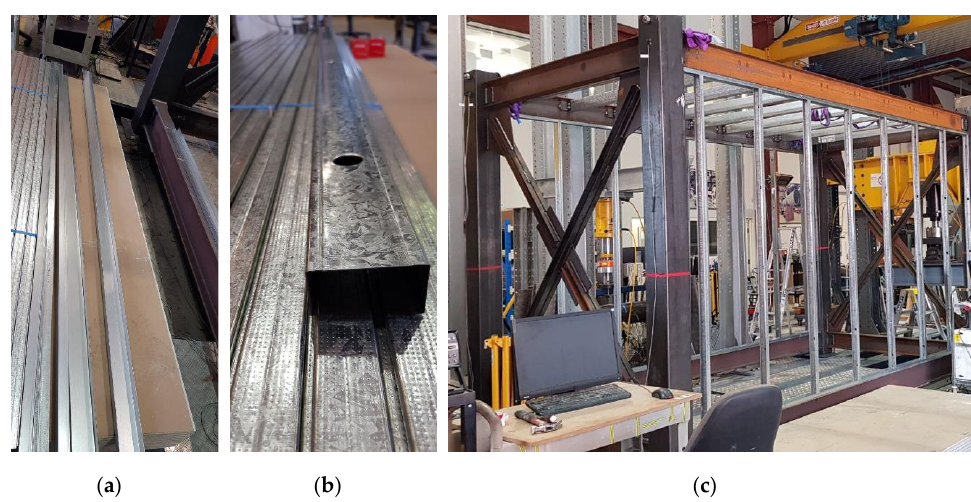
Figure 3. ( a ) Steel tracks, ( b ) studs, and ( c ) completed LSF assembly.